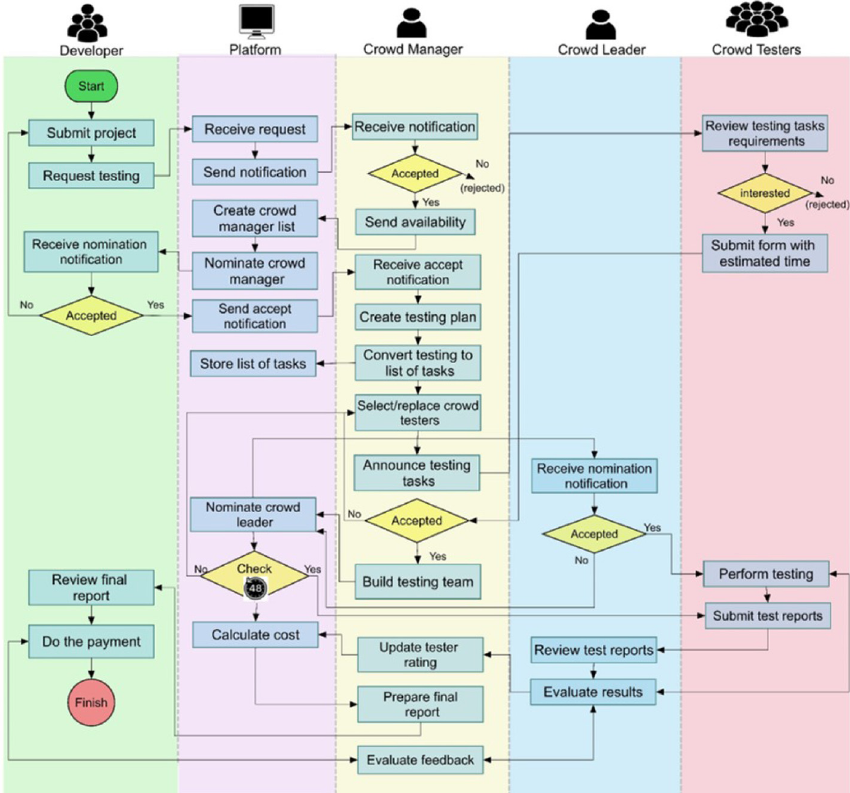
Figure 2. The most